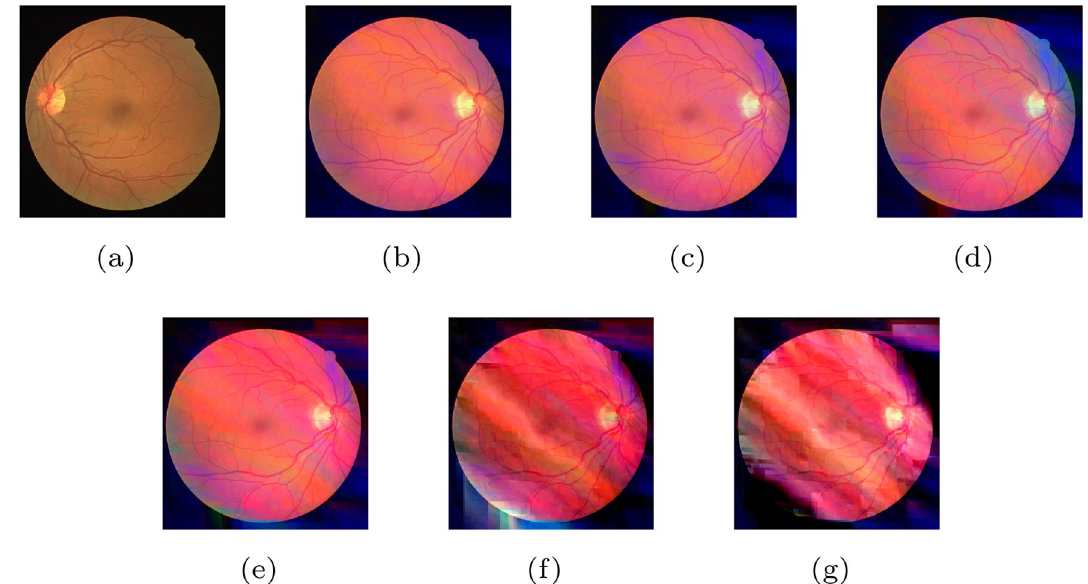
Figure 9. ( a ) The original image. ( b ) The reconstructed image when the components ( V D ) are transmitted in the BEC. ( c ) The reconstructed image when the components ( V D , V S ) are transmitted in the BEC. ( d ) The reconstructed image when the components ( V D , V S , U D ) are transmitted in the BEC. ( e ) The reconstructed image when the components ( V D , V S , U D , and U S ) are transmitted in the BEC. ( f ) The reconstructed image when the components ( V D , V S , U D , U S and Y D ) are transmitted in the BEC. ( g ) The reconstructed image when